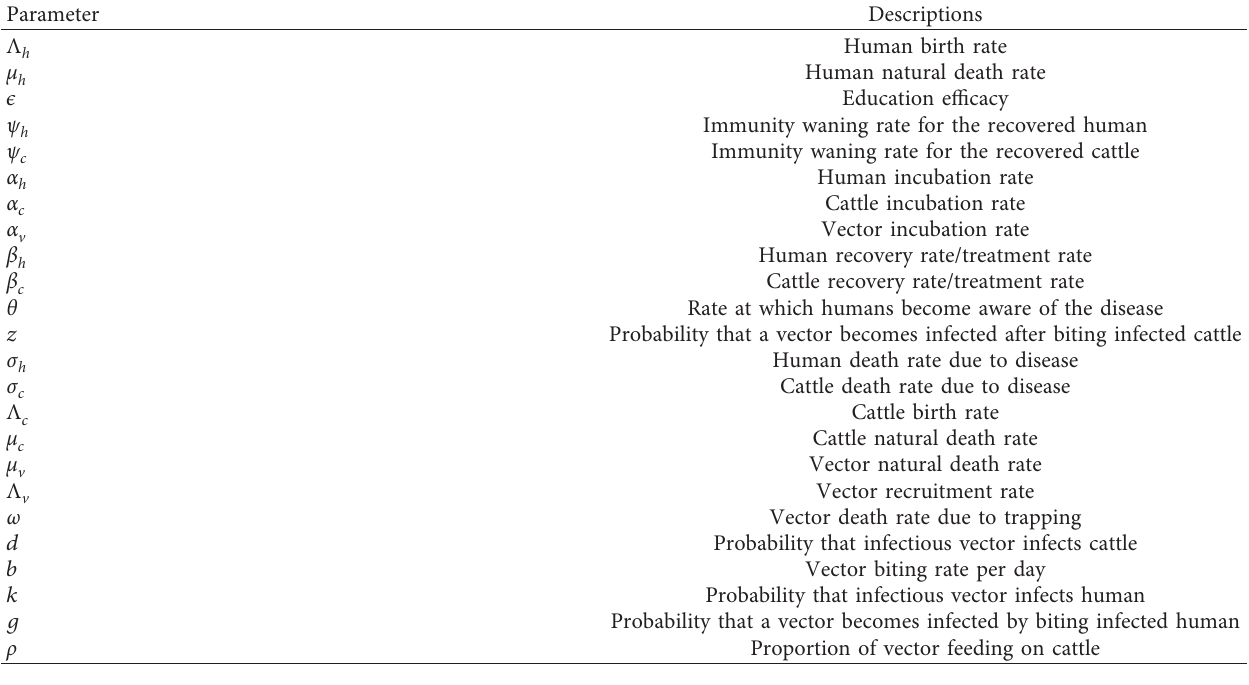
Table 2: Description of parameters of model (4).